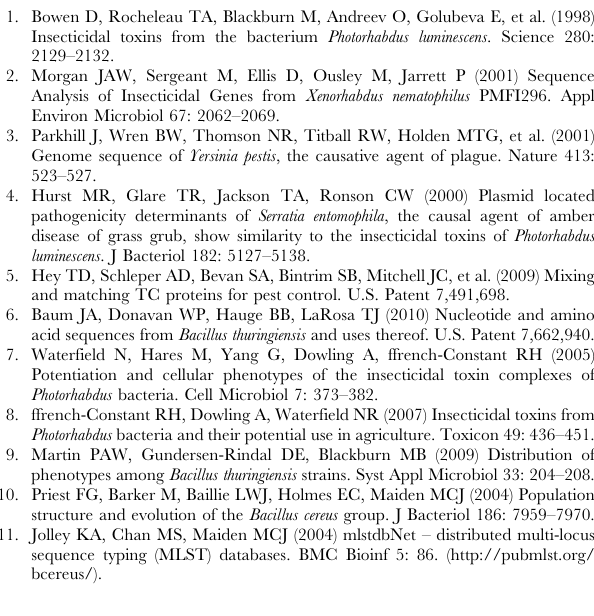
Table S1 Isolates utilized in the current study.